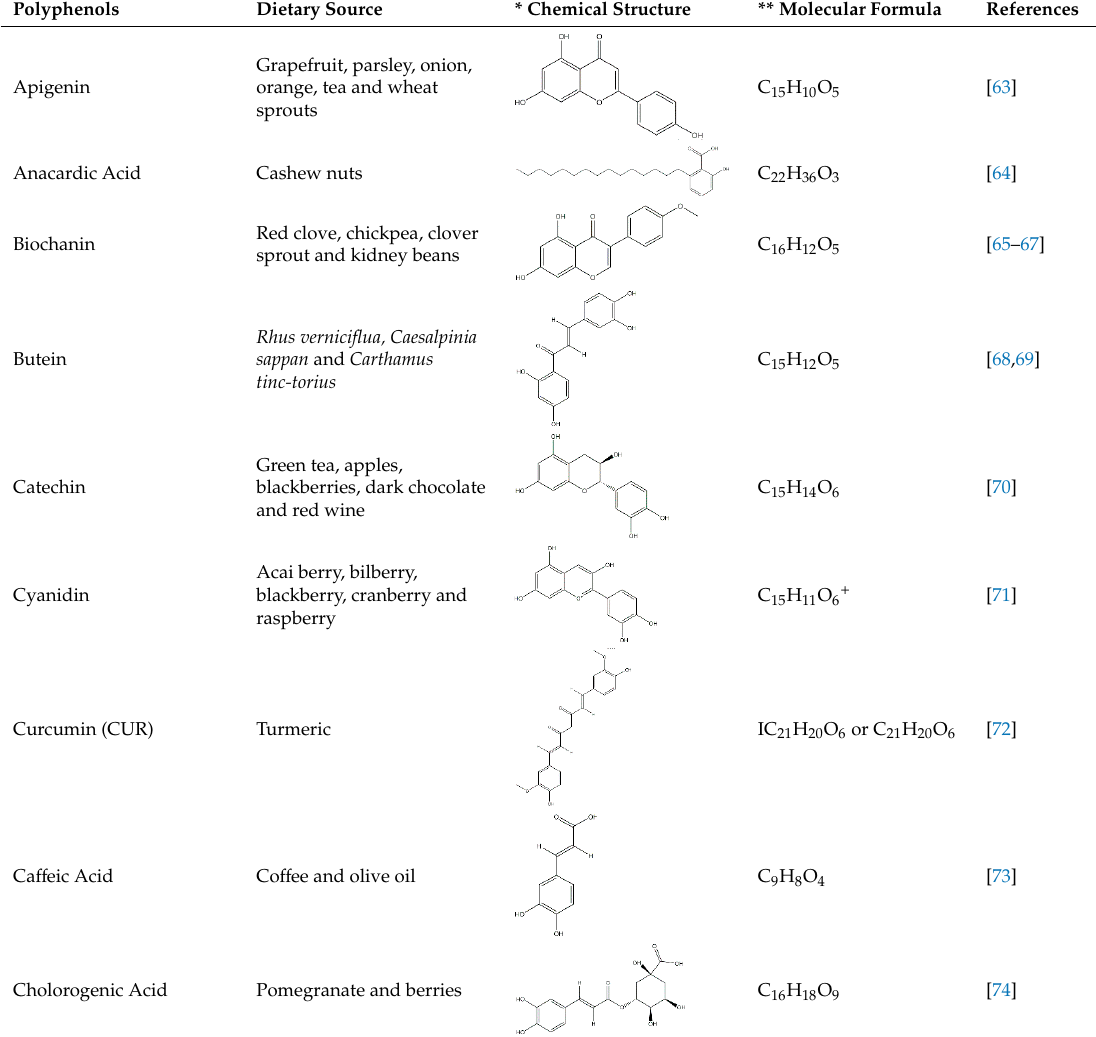
Table 1. Classification of polyphenols, chemical structure, molecular formula and their dietary source availability.